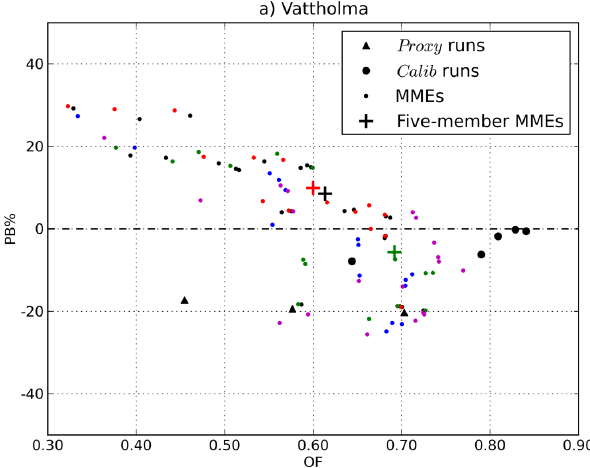
Fig. 3a. Criteria value for the different multi-model ensemble (MME) predictions at Vattholma. Two poor Proxy runs with low OF values are not shown and colours correspond to the different data-fusion methods (red: ME; black: WM; green: MD; blue: UR; magenta: CR; see Table 2 for abbreviations).